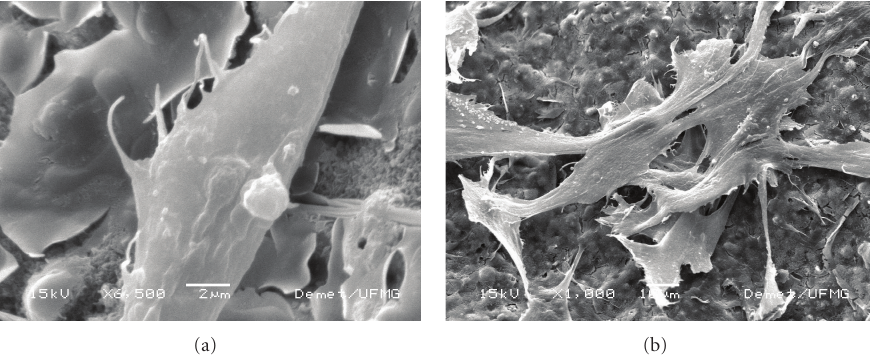
Figure 7: SEM micrographs of the morphology of osteoblast cultured on LiHA matrix for 120 hours. (a) Detail of cell surface showing secretion vesicles indicating normal physiology. Cells are flattened and elongated. Scale bar: 2 μ m. (b) Group of osteoblasts showing a flattened cellular body and a high degree of interconnection. Scale bar: 10 μ